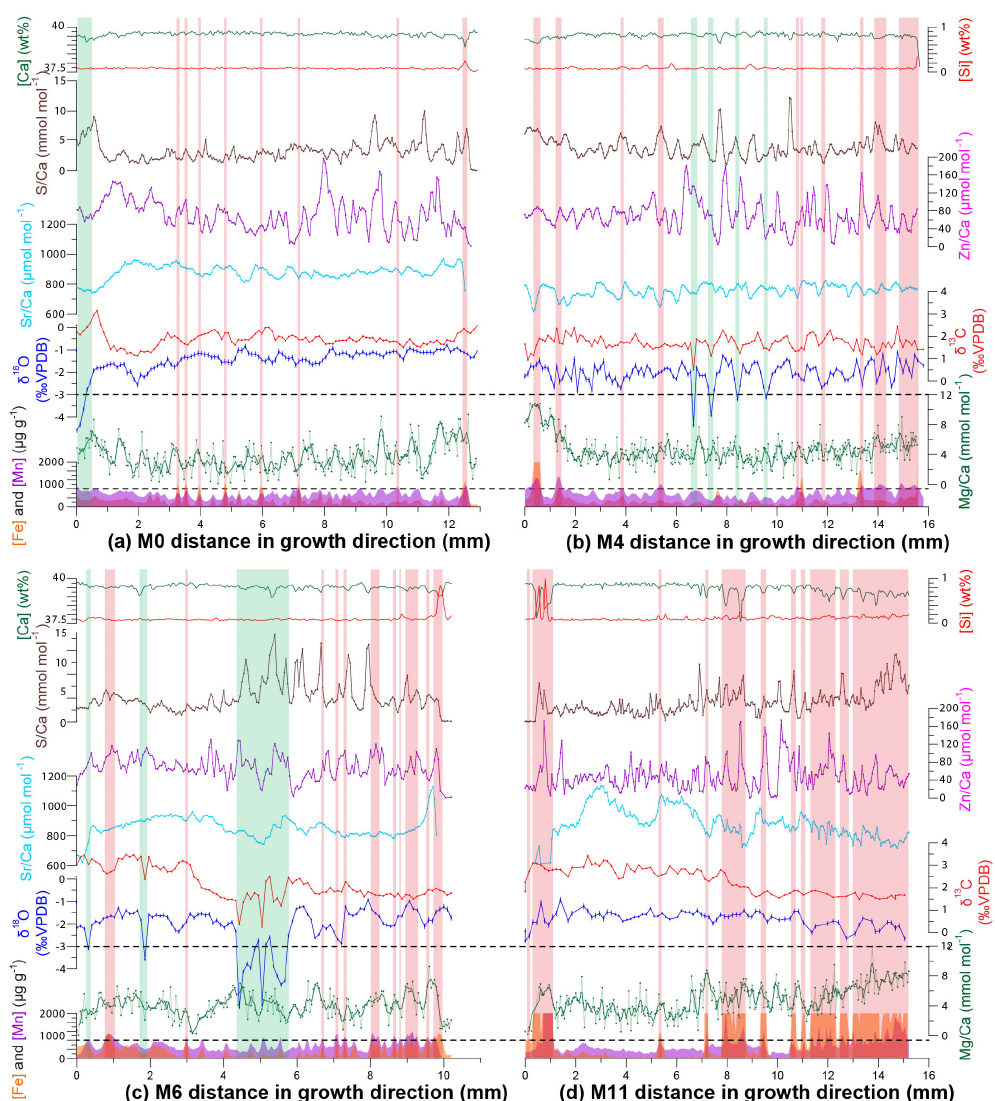
Figure 5. Overview of multi-proxy records through the hinges of four specimens of P. vesicularis . From top to bottom, records of Ca (green), Si (red), S / Ca ratios (brown), Zn / Ca ratios (purple), Sr / Ca ratios (light blue), δ 13 C (red), δ 18 O (blue), Mg / Ca (green), Mn (purple) and Fe (orange) are shown. Red arrows in Fig. 2 indicate the direction of sampling. Vertical bars indicate parts of the records that were affected by diagenesis based on Mn and Fe concentrations (red bars) and stable isotope ratios (green bars). Note that the vertical scale of the Mn and Fe plots is clipped at 2000µgg − 1